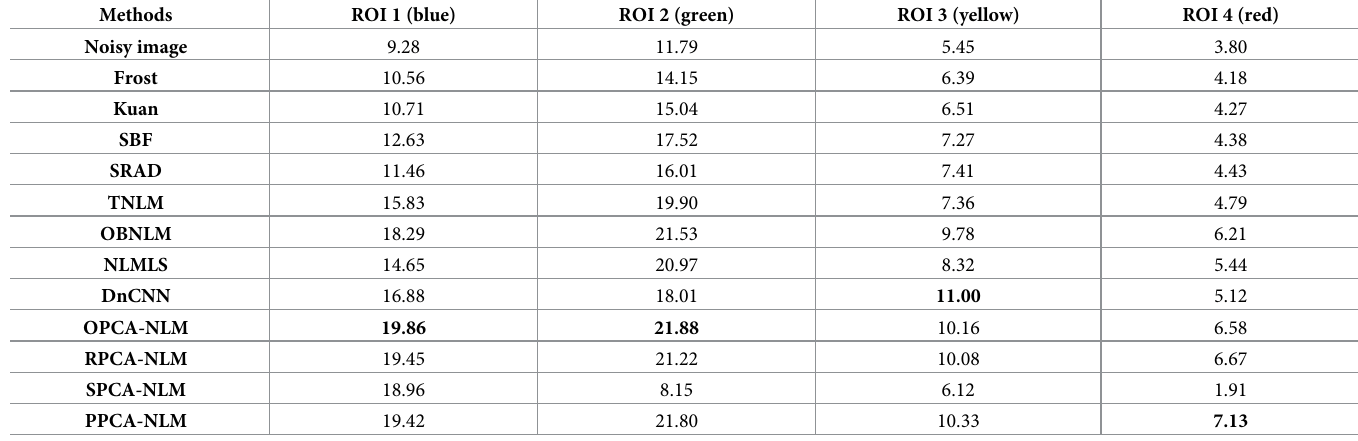
Table 6. The CNR values of four ROIs on a real ultrasound image.